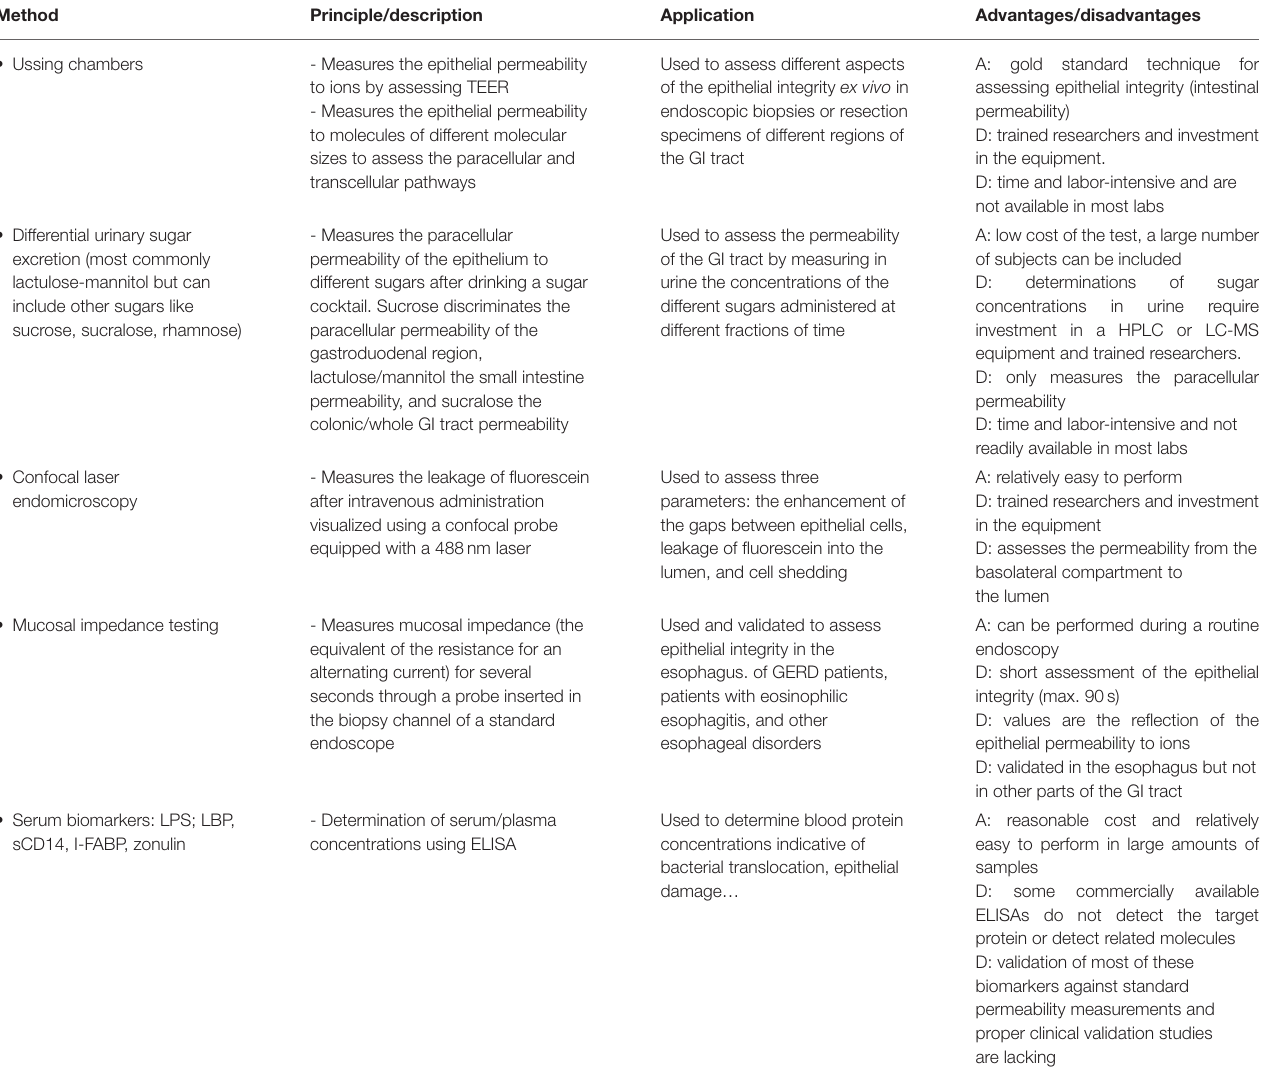
TABLE 1 | Summary table of the different methods to assess intestinal